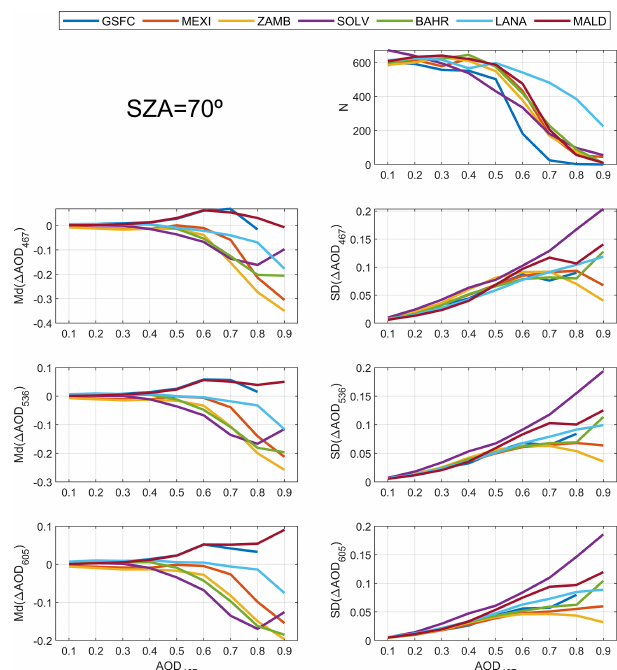
Figure 5. Median (Md) and standard deviation (SD) of the (cid:49) dif- ferences between the available retrieved aerosol properties with noise-perturbed radiances and the original (reference) properties. The amount of available retrievals ( N ) is also shown. Only the retrievals with solar zenith angle (SZA) equal to 70 ◦ are used. The aerosol properties provided are aerosol optical depth (AOD) at 467nm (AOD 467 ), 536nm (AOD 536 ) and 605nm (AOD 605 ). The Md and SD are represented as a function of AOD 467 for different aerosol